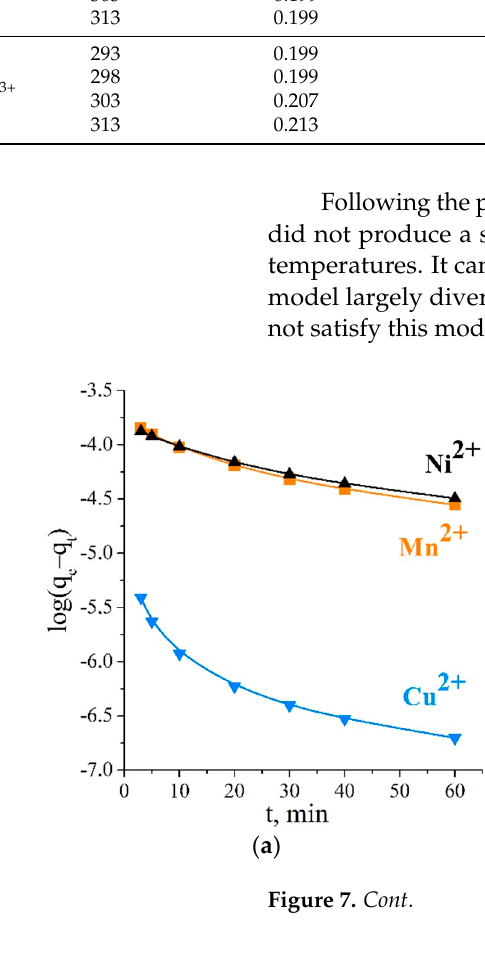
Table 2. Kinetic parameters of pseudo-second-order model for sorption of studied ions on Li-TiOP sorbent at different temperatures.